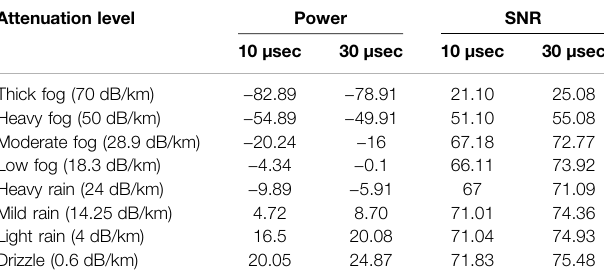
TABLE 2 | Power and SNR values obtained at different attenuation levels. Attenuation level